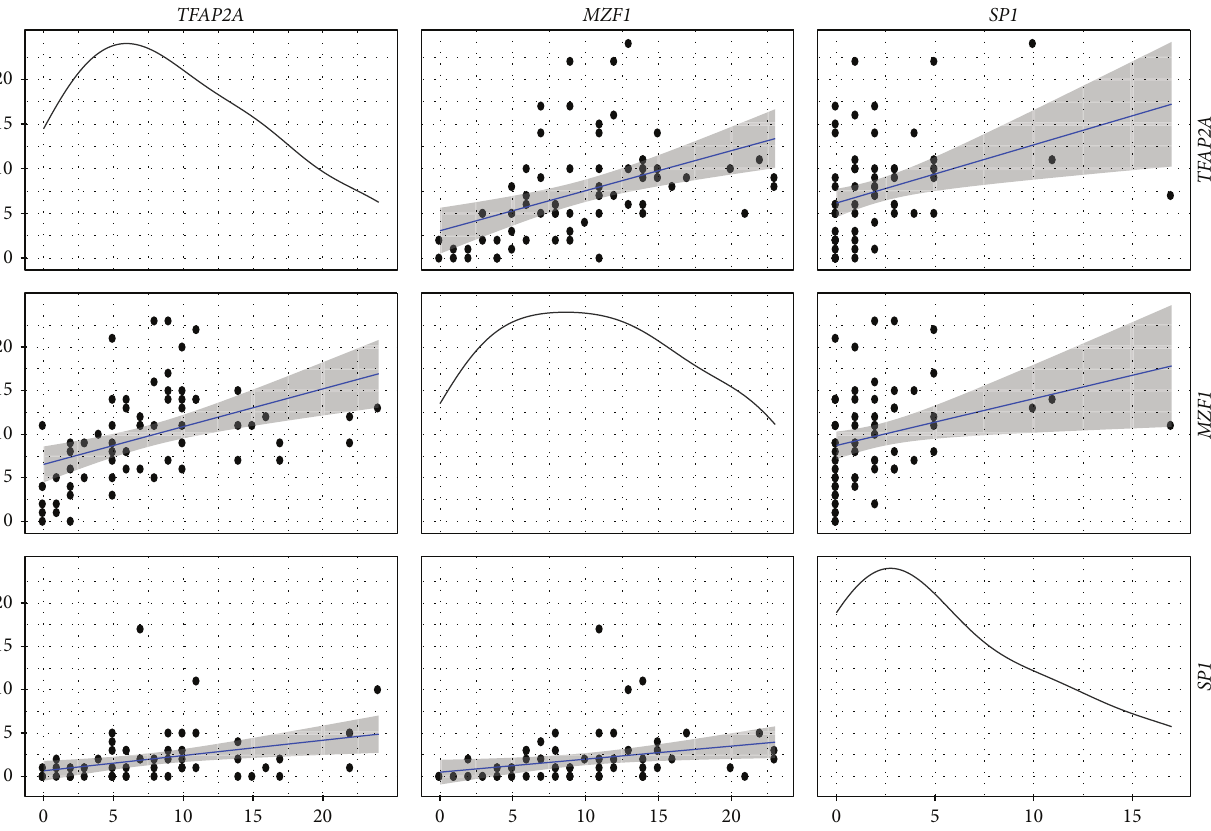
Figure 5: Correlation coefficients calculated between transcription factor binding sites (TBFSs) to estimate potential interaction and regulatory control of Wnt pathway genes. The number of binding sites identified for each motif was compared using Spearman’s rank correlation. TFAP2A and MZF1 ( 𝑟 2 = 0.59 ; 𝑃 = 1.87 × 10 −7 ); TFAP2A and SP1 ( 𝑟 2 = 0.46 ; 𝑃 = 1.09 × 10 −4 ); MZF1 and SP1 ( 𝑟 2 = 0.41 ; 𝑃 = 6.26 × 10 −4